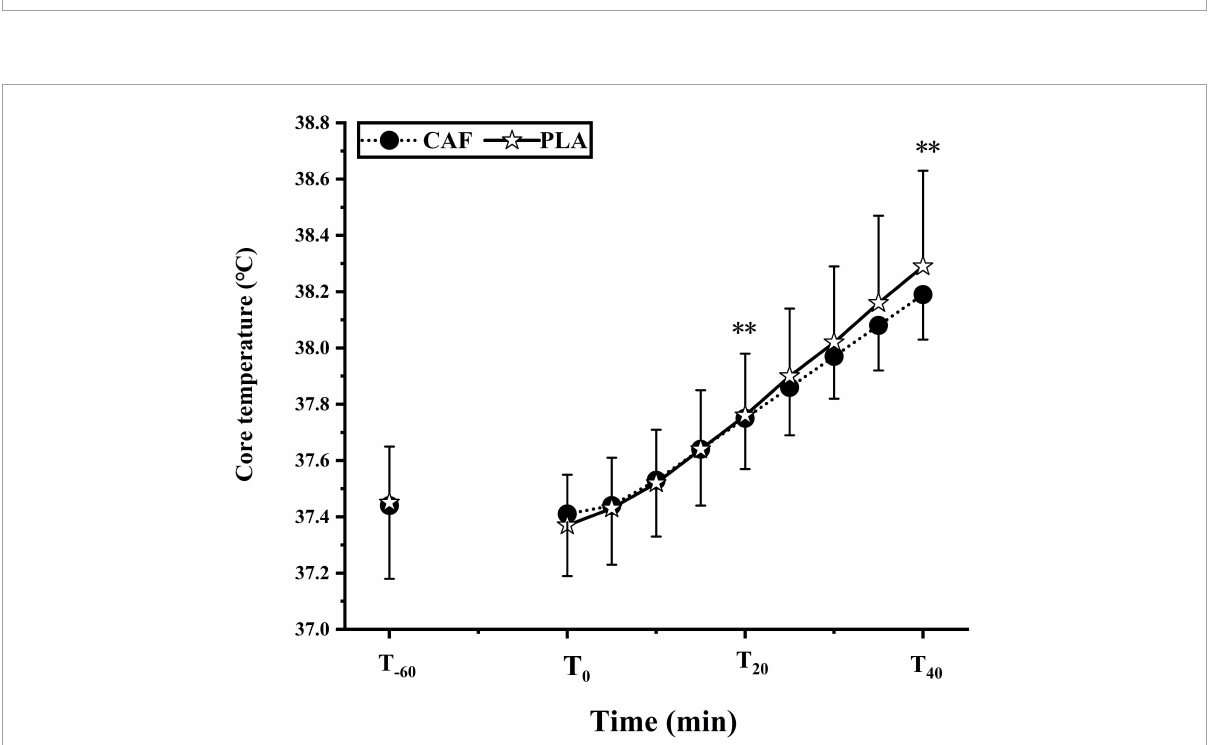
FIGURE4 The change of core temperature in two trials. Data are mean ± standard deviation ( n = 12). ∗∗ p < 0.01 vs. T 0